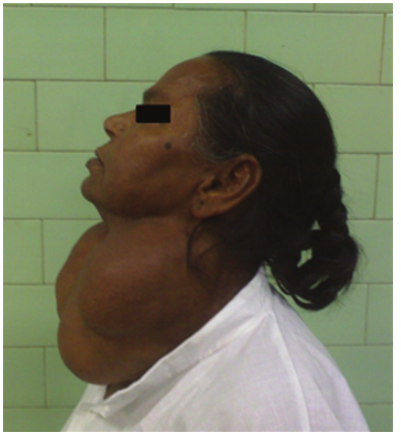
Figure 2: Lateral view of